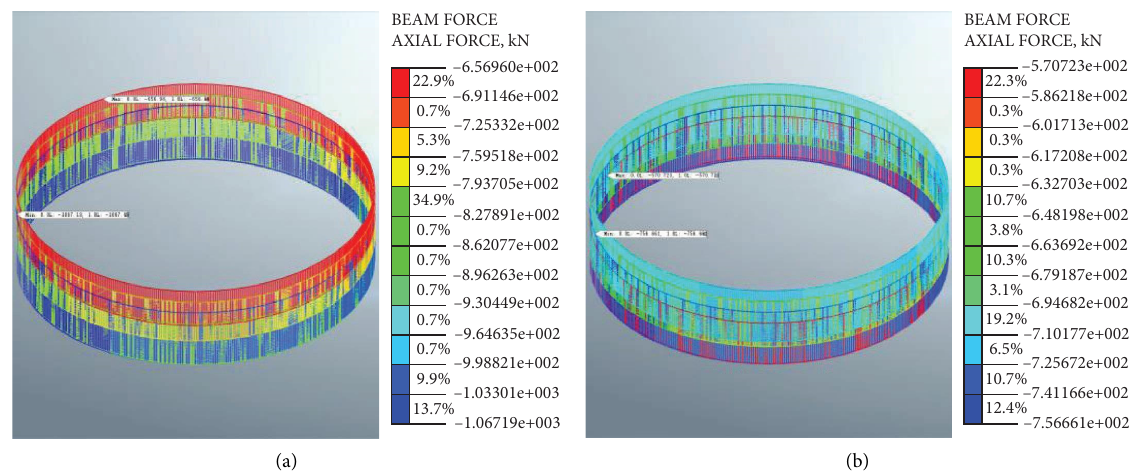
Figure 32: Working condition 5 lining axial force (a) without pore water pressure and (b) with pore water pressure